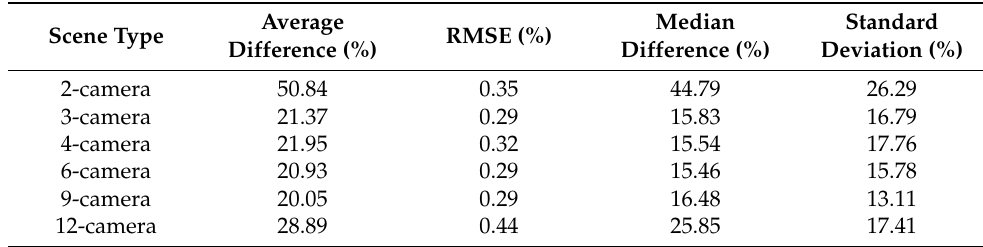
Table 4. Statistics for differences between predicted and evaluated accuracy under different scenarios with outliers